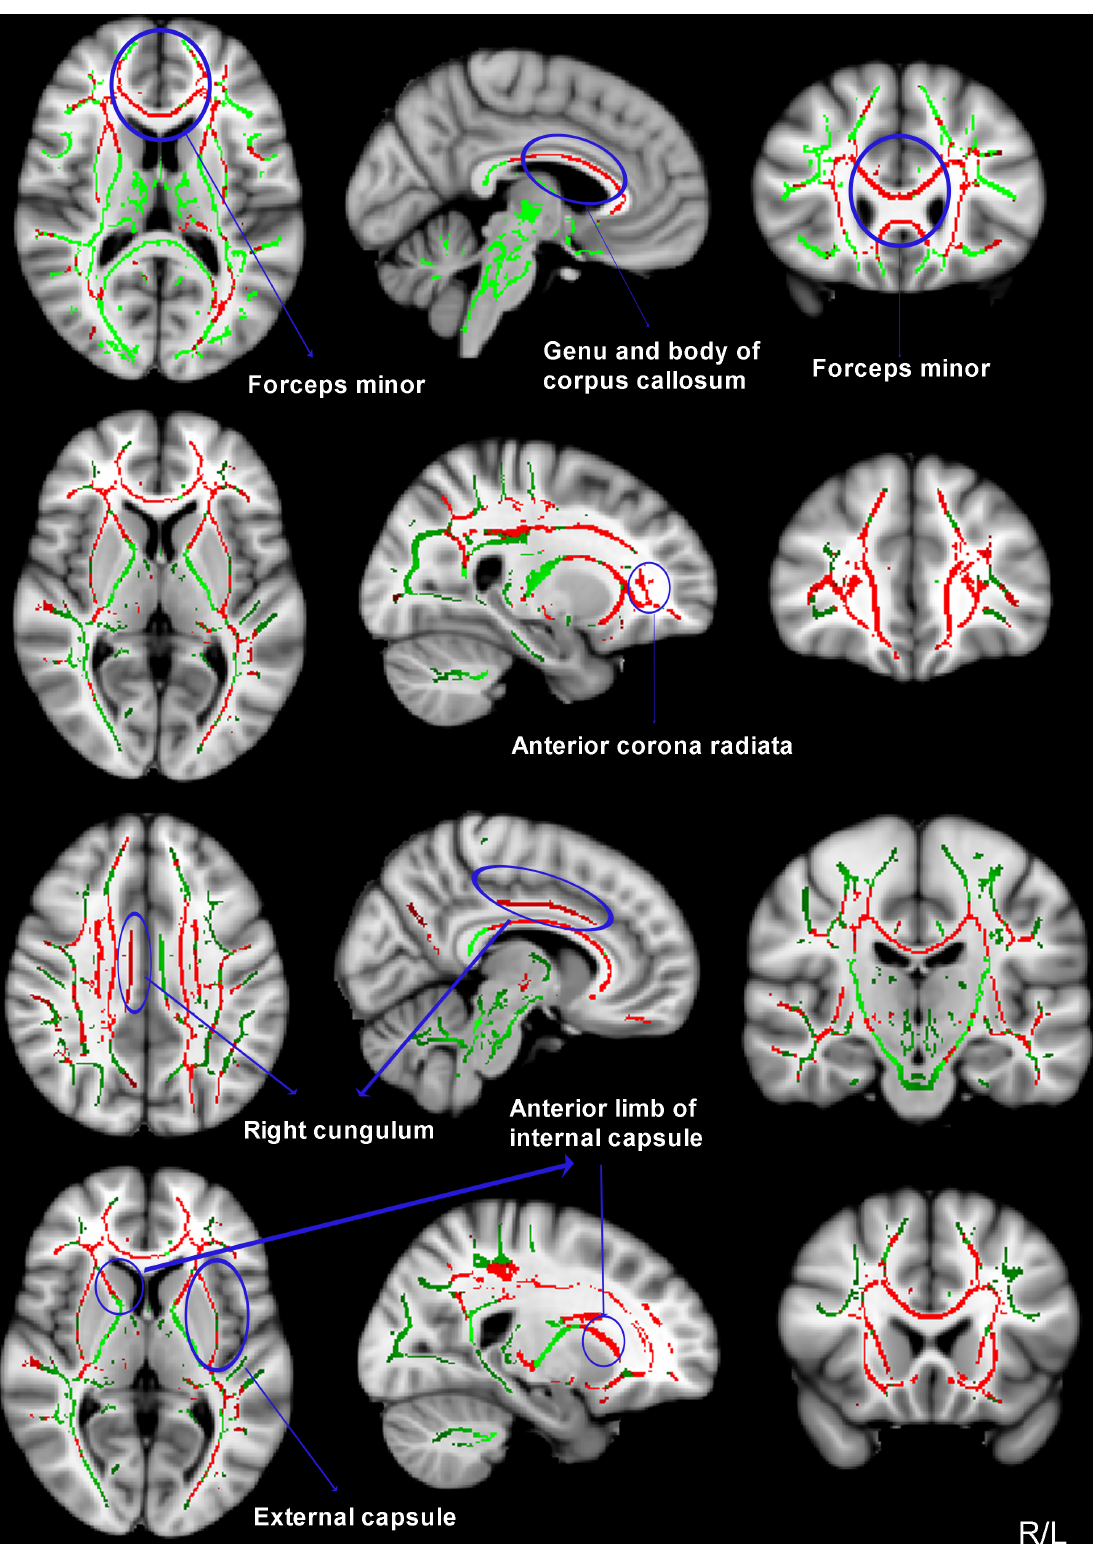
Fig 4. TBSS analysis of FA reduction (red) in ADPs versus HCs ( p < 0.01, corrected by TFCE). Results are overlaid on MNI152-T1 template and the mean FA skeleton (green). The left of the image corresponds to the right hemisphere of the brain.